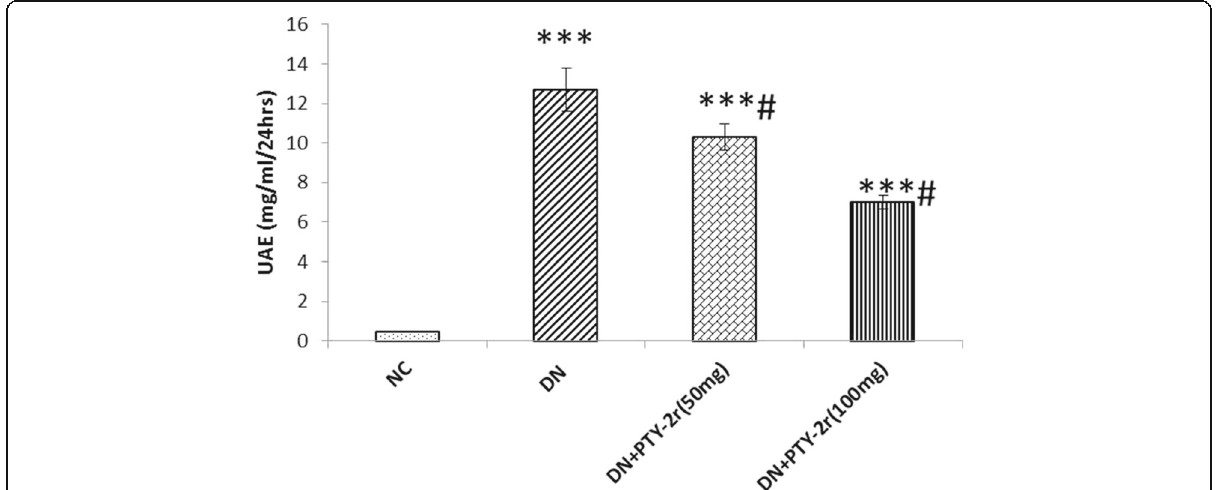
Fig. 5 Effects of PTY-2r on urinary albumin excretion (UAE): NC, DN control, DN + PTY-2r (50 mg/100 g) and DN + PTY-2r (100 mg/100 g). Data are presented in mean ± SD ( n = 6 in each group). *** p < 0.001 compared with group-1; # p < 0.001 compared with